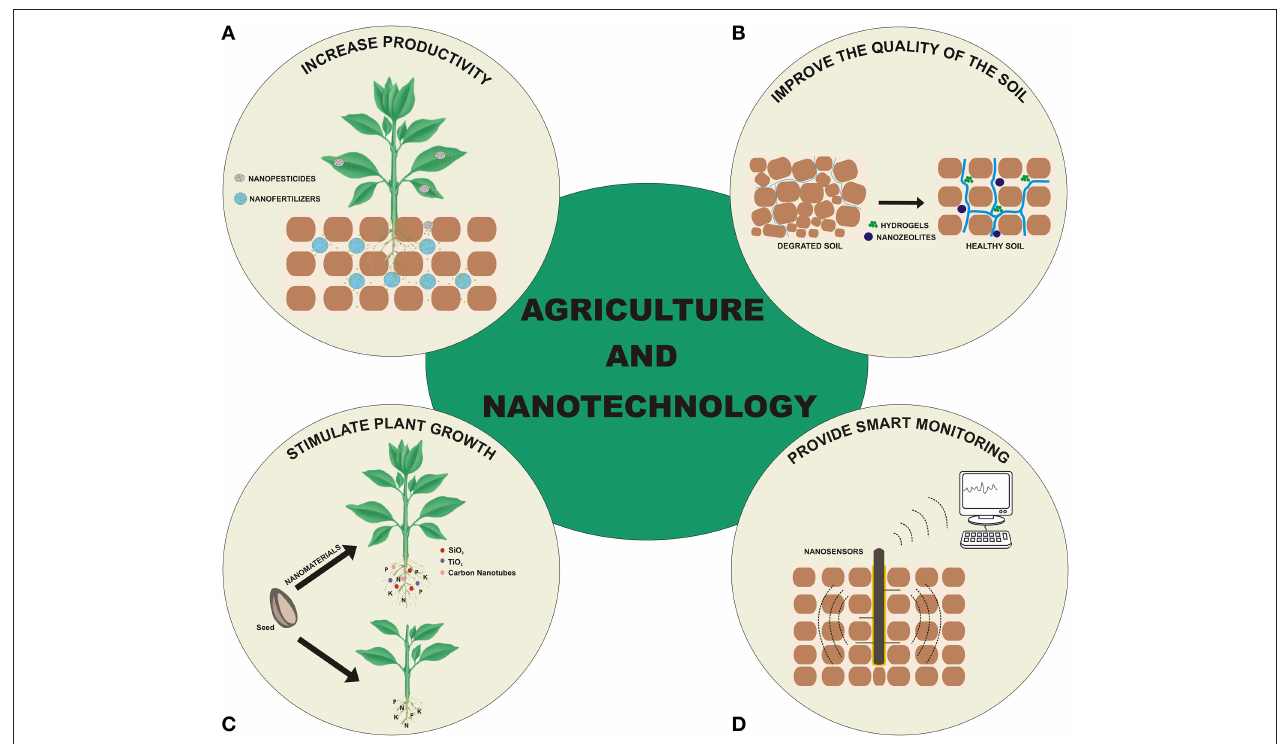
FIGURE 1 | Potential applications of nanotechnology in agriculture. (A) Increase the productivity using nanopesticides and nanofertilizers; (B) Improve the quality of the soil using nanozeolites and hydrogels; (C) Stimulate plant growth using nanomaterials (SiO 2 , TiO 2 , and carbon nanotubes); (D) Provide smart monitoring using nanosensors by wireless communication